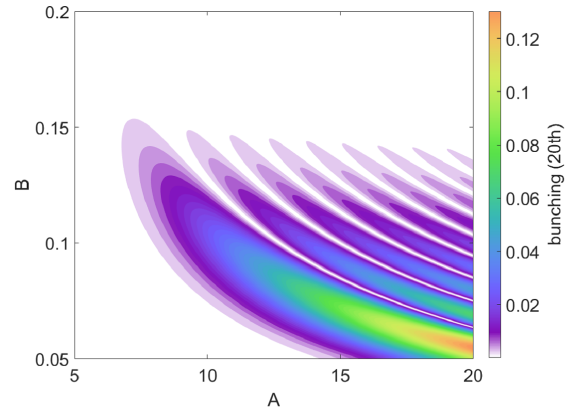
FIG. 5. The dependence of the bunching factor of the 20th harmonic with respect to the two parameters A and B ( A ¼ Δ E